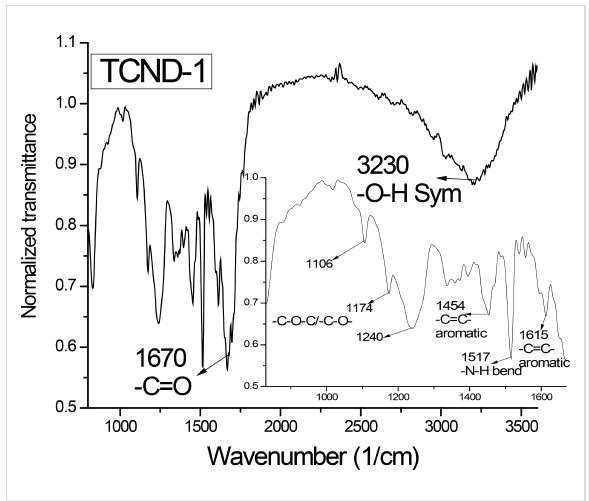
Figure 3: Illustration of recorded FTIR spectrum of TCND-1.